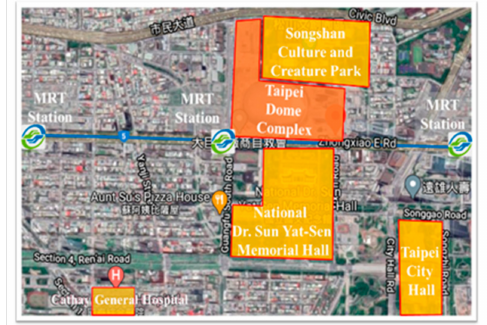
Figure 1. Geographical location.